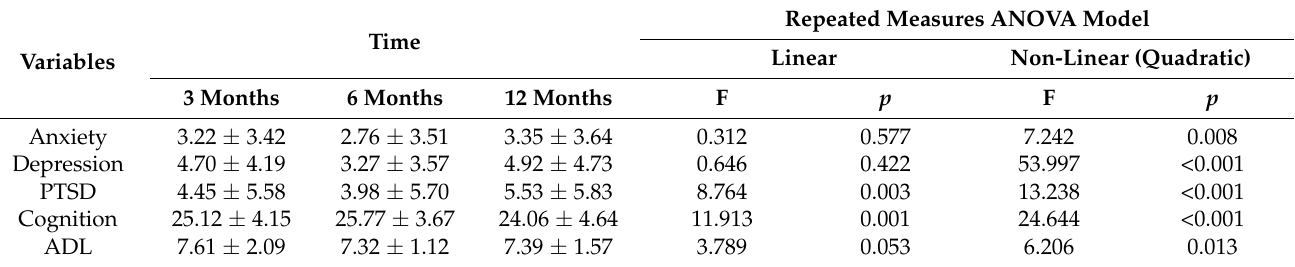
Table 3. Differences in the change of PICS scores according to time in groups A and B.